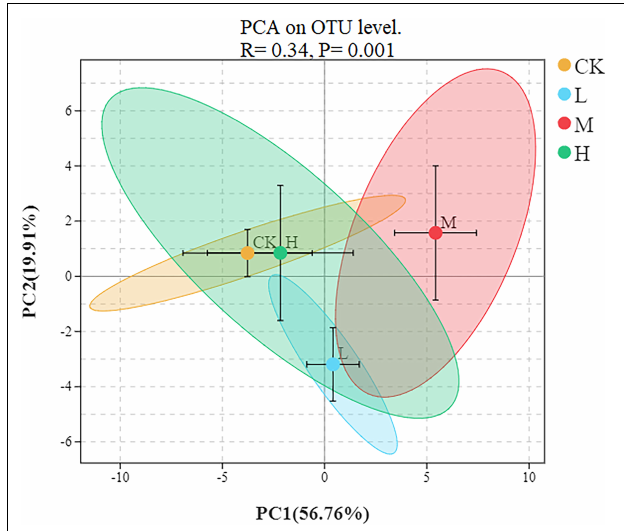
FIGURE 5 | Principal component analysis at the OTU level of rhizosphere soil. Different ellipses indicate different treatment, the tick mark inside each ellipse represent standard